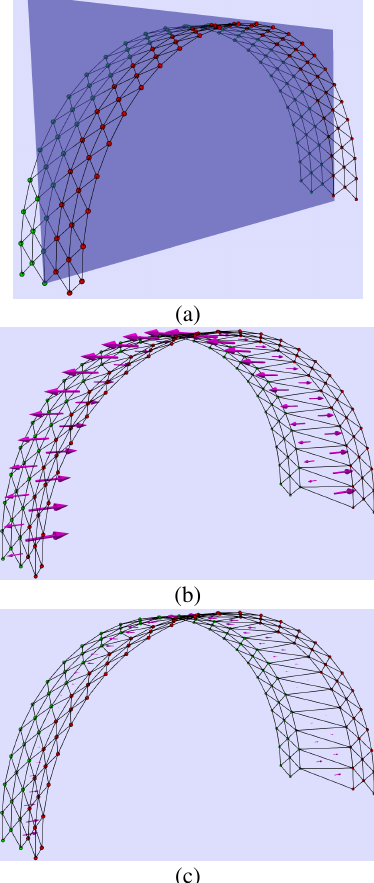
Table 2. Median absolute and relative errors for 3D case.